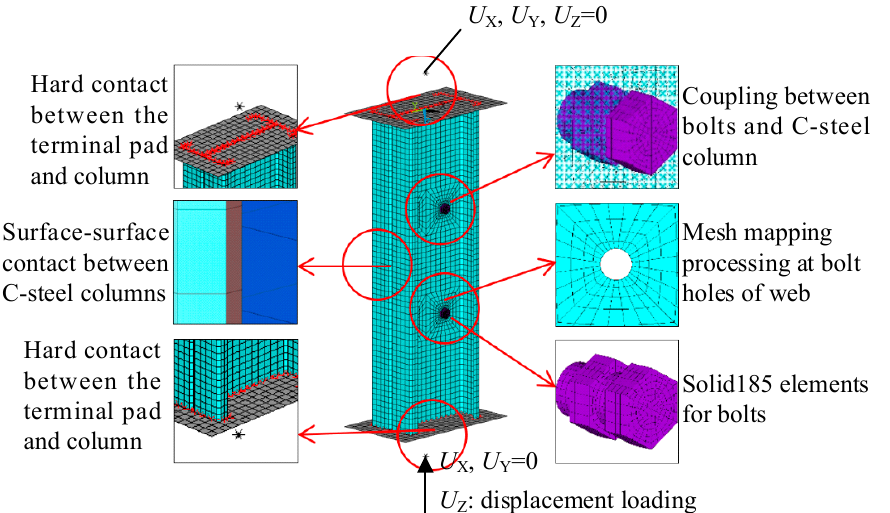
Figure 4. Finite element models of the C-steel combined I-section columns.